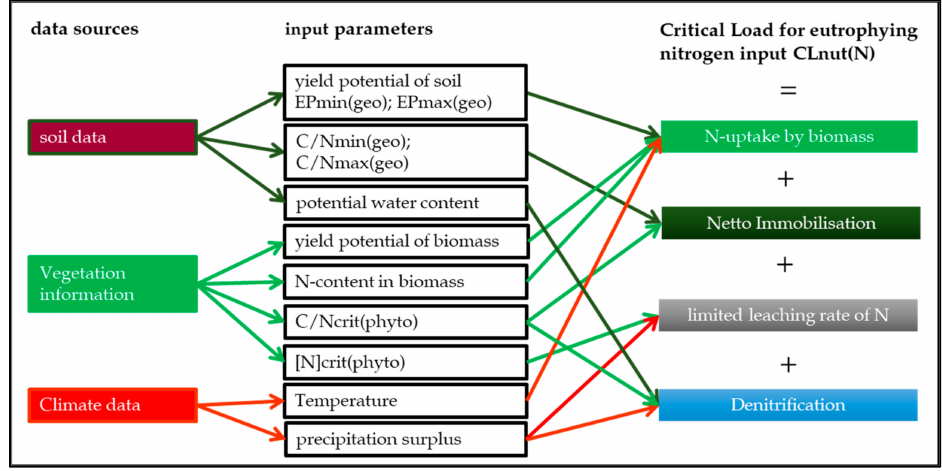
Figure 1. Flowchart of data sources, input parameters and critical load terms for